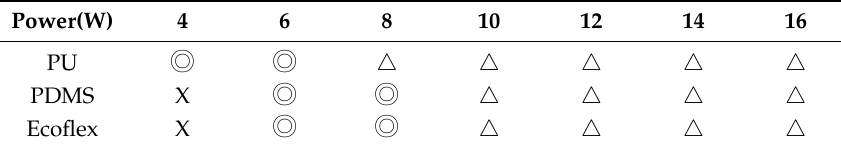
Table 1. Laser cutting test using the output of each material.